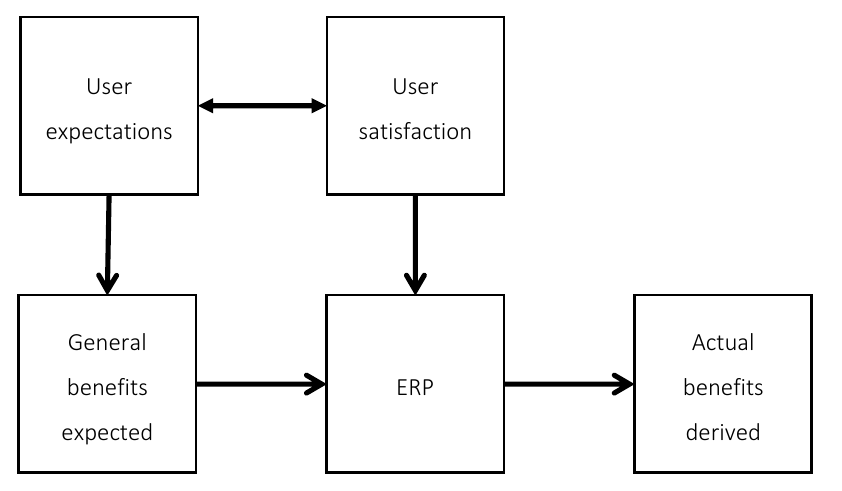
Figure 1. Conceptual framework developed from DeLone and McLean IS success model